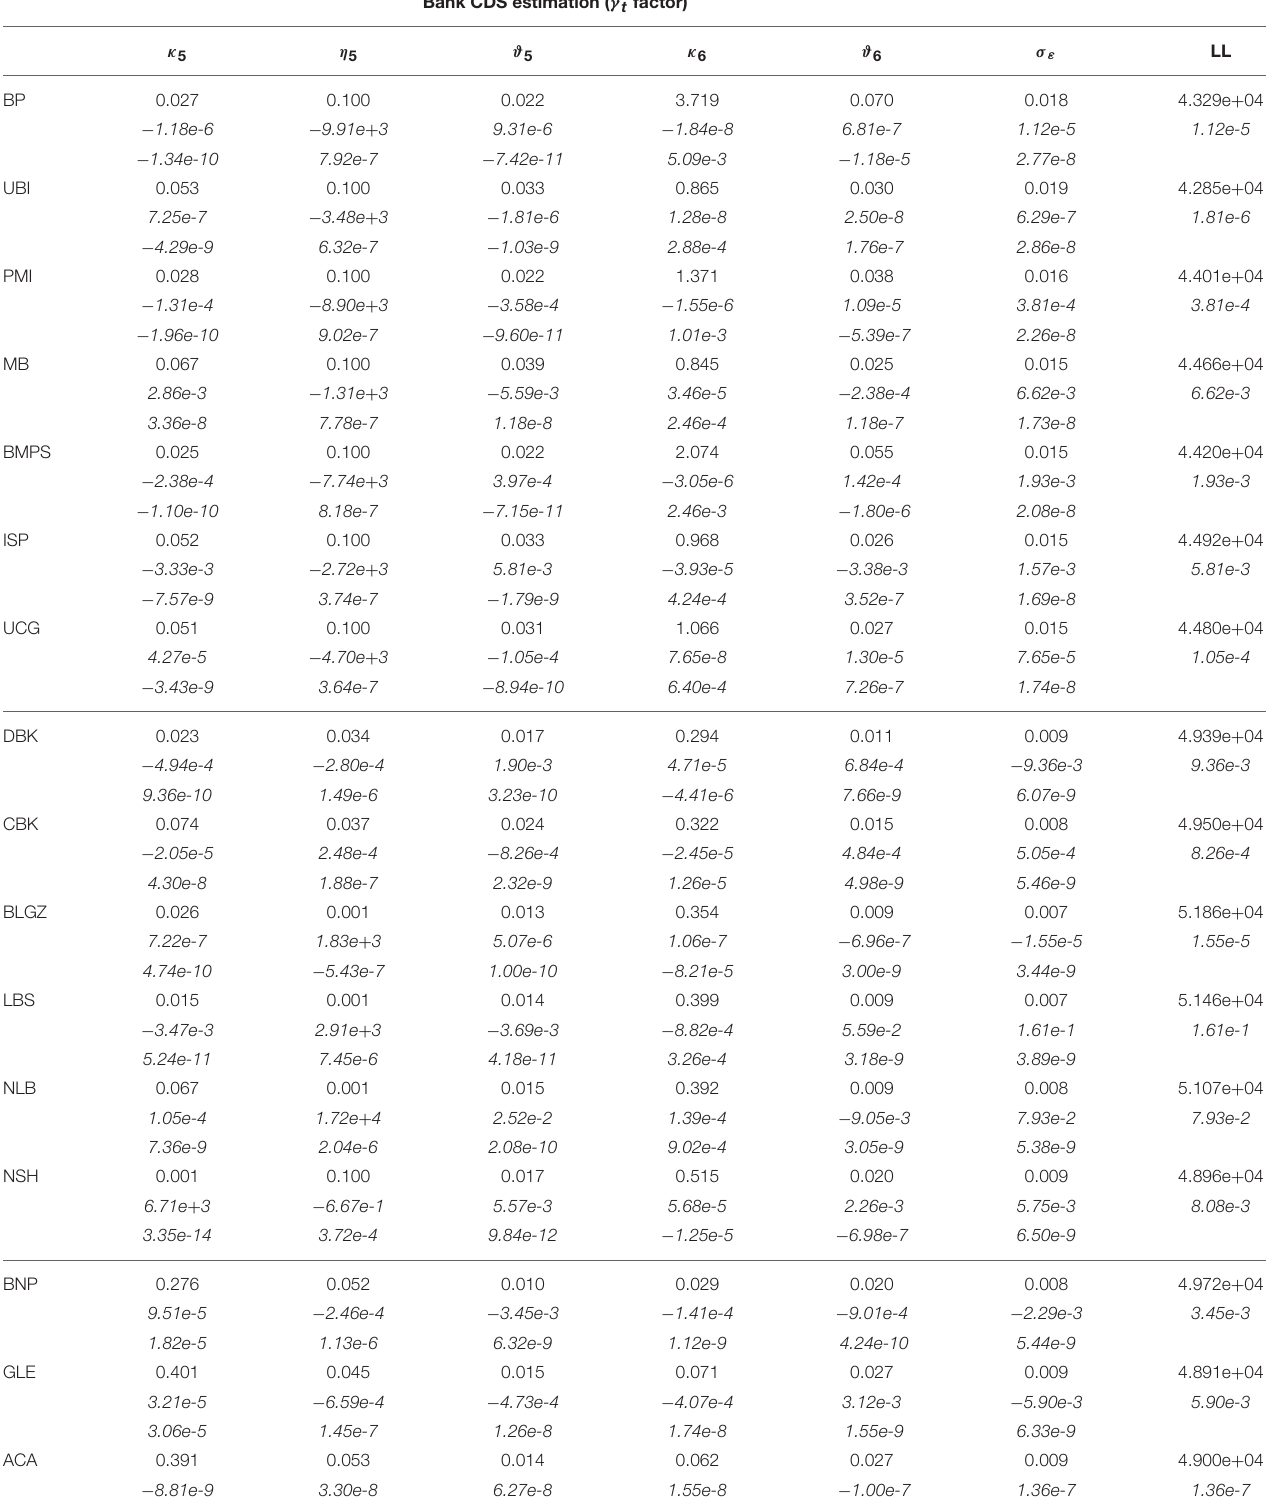
TABLE 10 | Estimated parameters of the multi-factor Vasicek